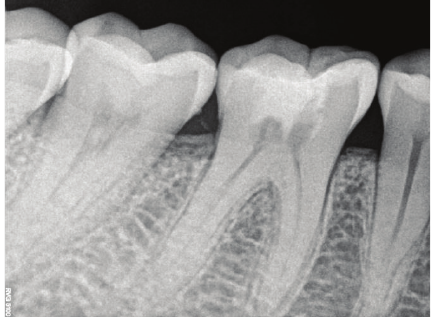
Figure 39: 3-month followup RVG 36.